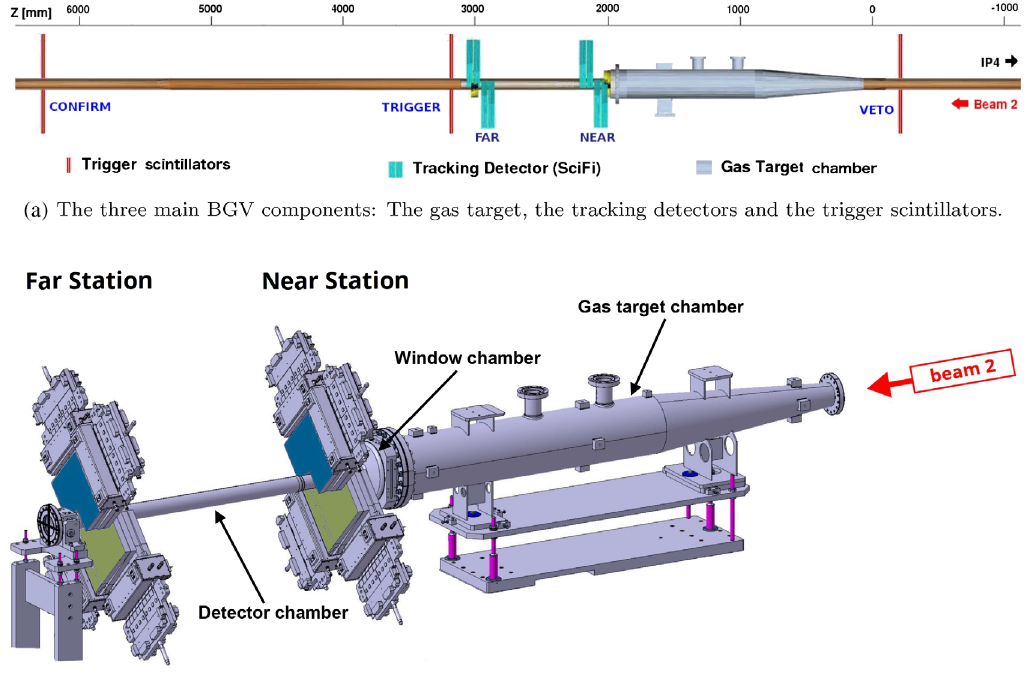
FIG. 1. A schematic drawing of the BGV